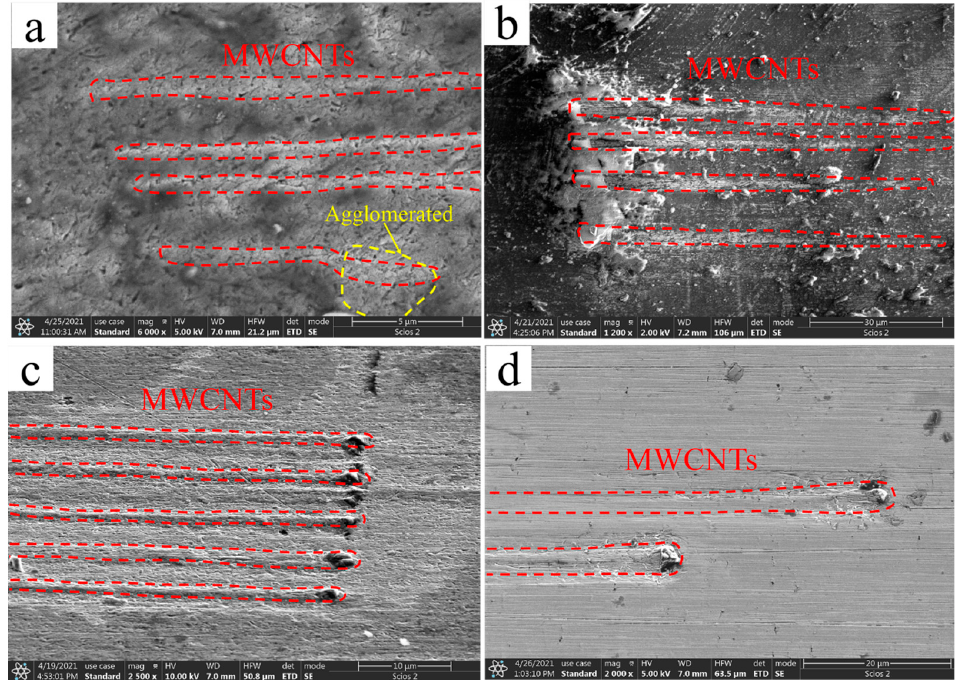
Figure 3. SEM images of ( a ) MWCNTs/Cu composite, ( b ) Cu@CNTs/Cu composite, ( c ) Ni@CNTs/Cu composite, ( d ) Ni&Cu@CNTs/Cu composite.